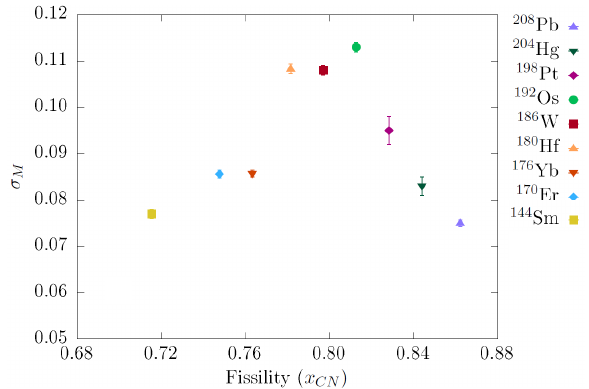
Figure 3. The measured mass widths, σ M , presented as a func- tion of the compound nucleus fissility, x CN , for reactions at E / V B = 1 . 0 ± 0 . 1. The error bars are determined from the calcu- lated errors in the standard distributions of the Gaussian fits for each reaction. The decrease in σ M between the 192 Os and 208 Pb reactions highlights that the entrance channel magicity domi- nates the e ff ect of an increased fissility of the